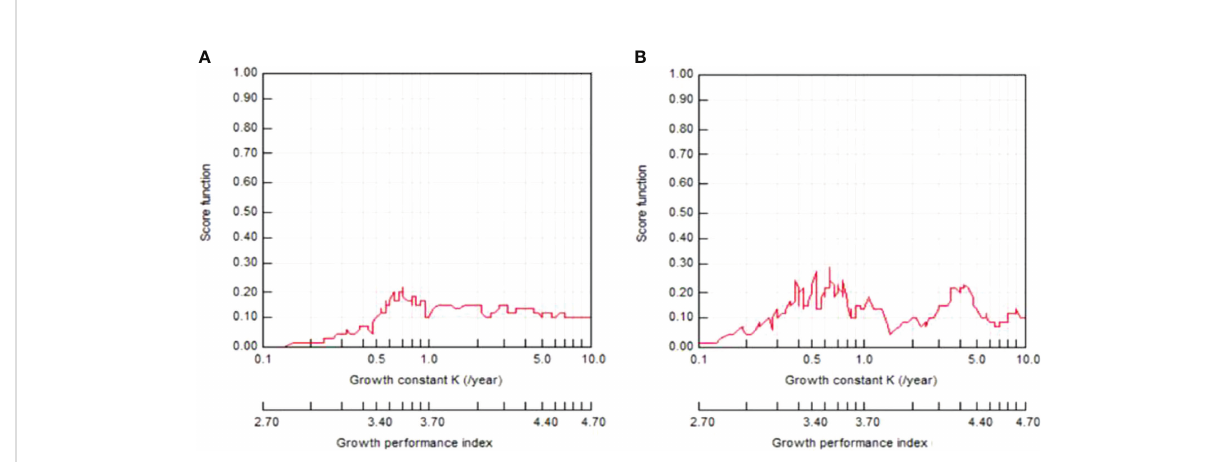
FIGURE 8 ELEFAN I K-scan routine FiSAT II output for (A) male and (B) female P. adspersus from the southeast Caspian Sea (2019 – 2020).